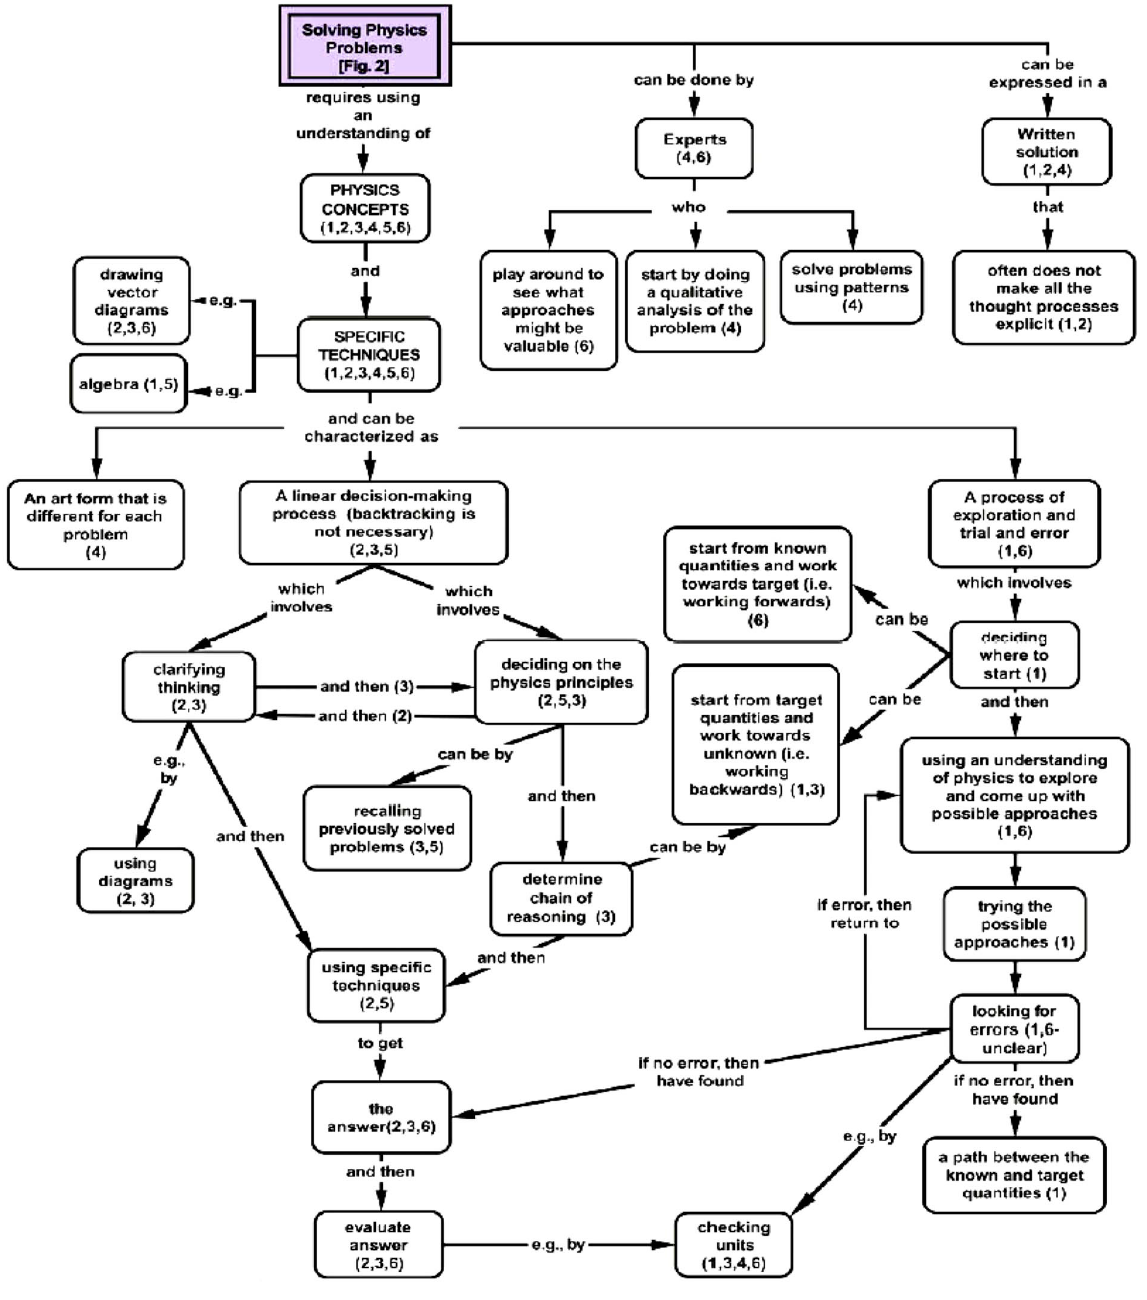
FIG. 2. (cid:1) Color (cid:2) “Solving Physics Problems” composite map of faculty beliefs about the problem-solving process in an introductory physics course. Numbers in the parentheses denote the instructor whose statements directly justify that category. Uppercase labels refer to specific types of knowledge that also occur in the “Appropriate Knowledge” composite map shown in Fig.